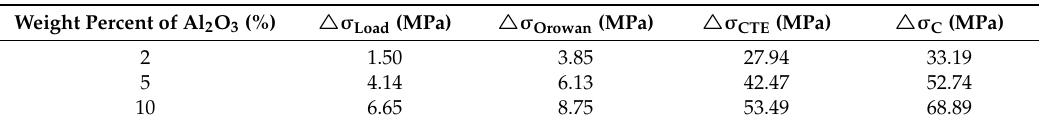
Table 3. Contribution of different strengthening mechanisms on the yield stress of Al-12Si/Al 2 O 3 extruded nanocomposites.